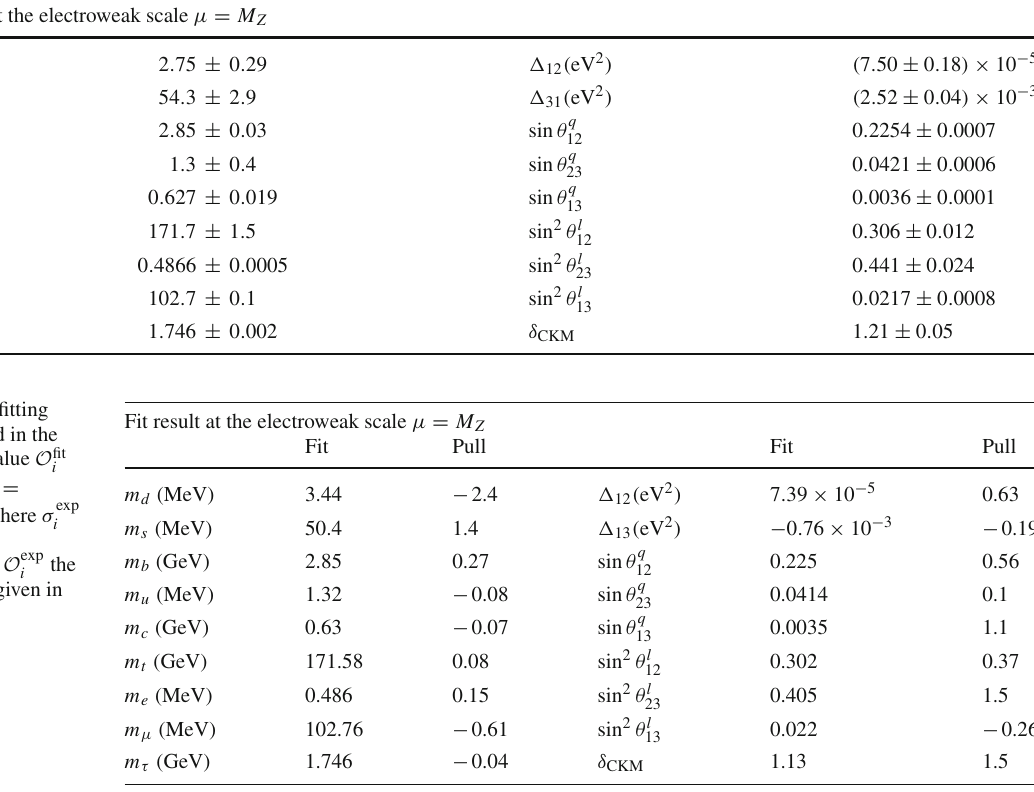
for the charged lepton masses in the fitting procedure. To simplify the fitting procedure, we used for all observables the arithmetic average of the errors when not symmetric